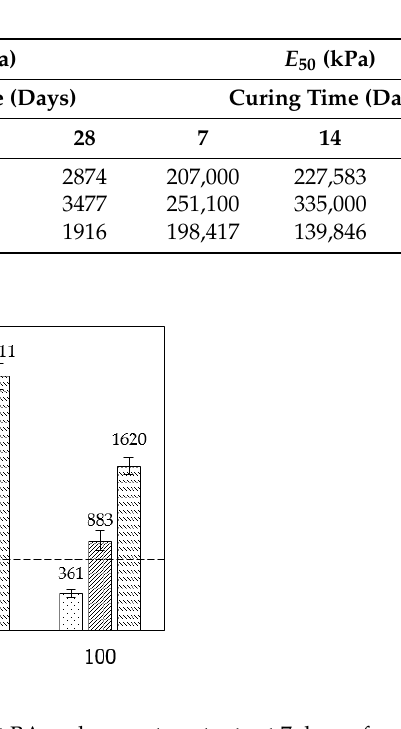
Figure 7. The q u of CSS specimens for different BA and cement contents at 7 days of curing time.